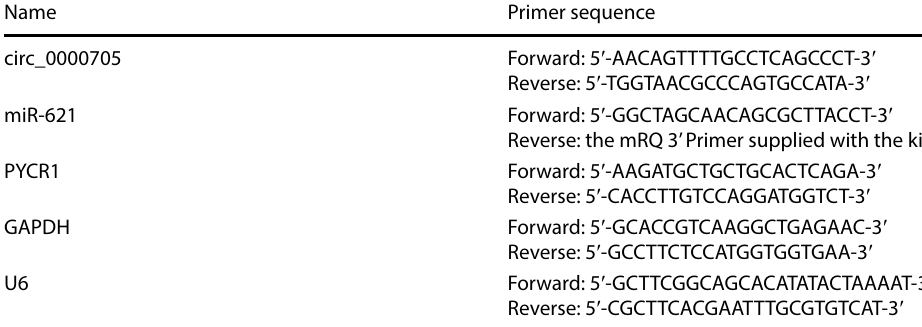
Table 1 qRT-PCR primer sequences